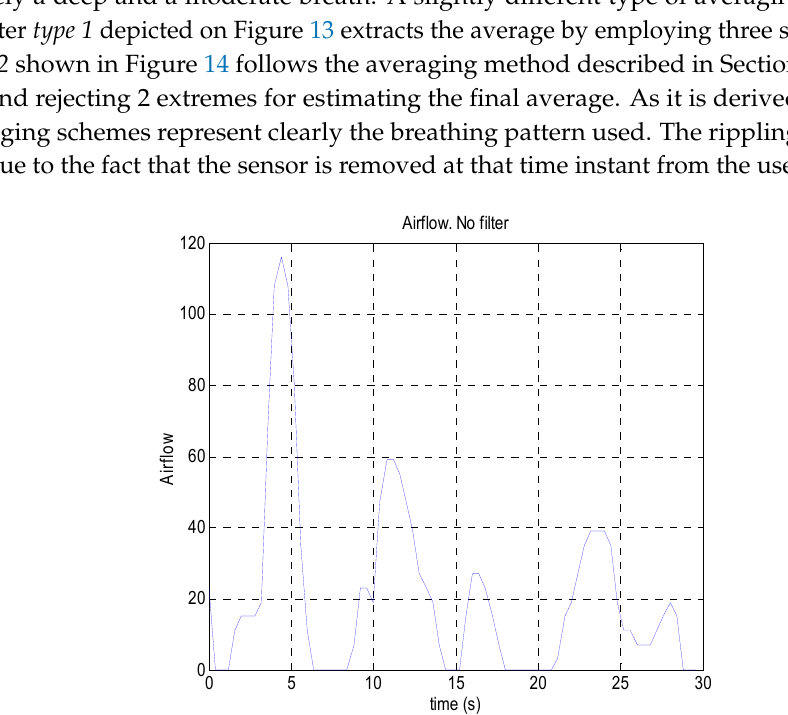
Figure 11. Comparison of the Libelium and the Shimmer GSR sensors behavior on the same person. The vertical dashed lines denote the corresponding local minima between the two sensors.